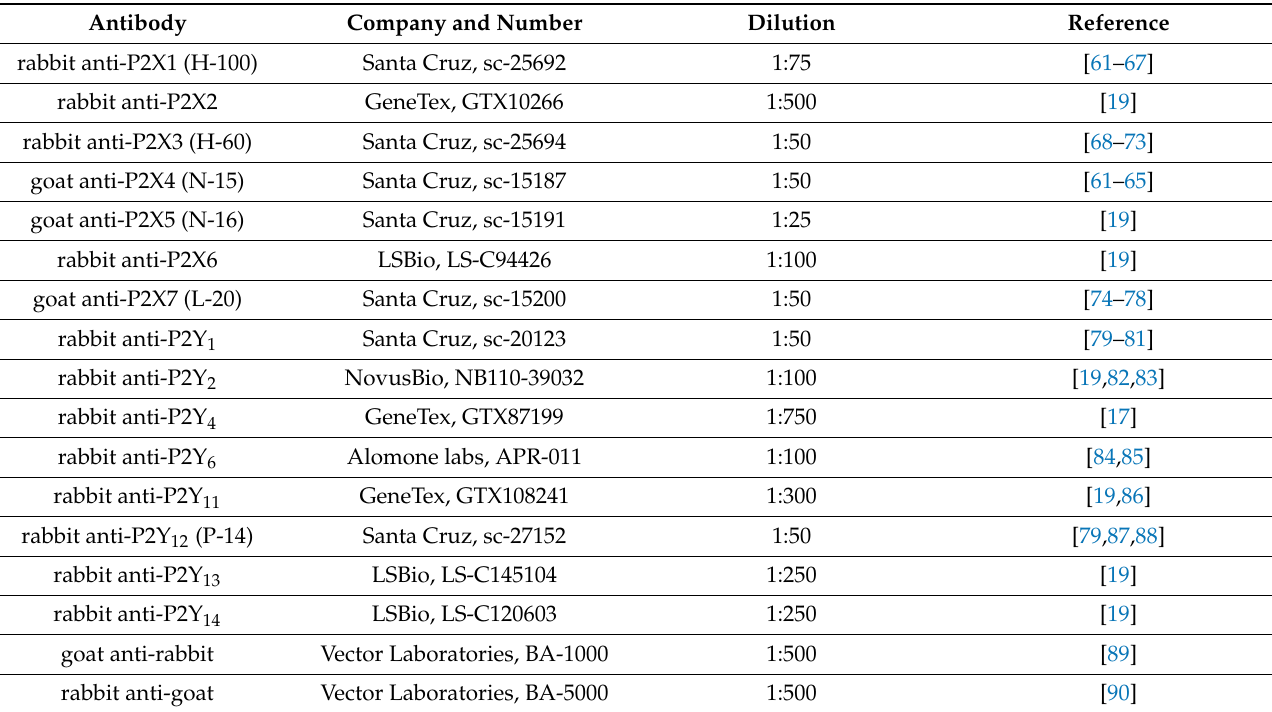
Table 4. List of primary and secondary